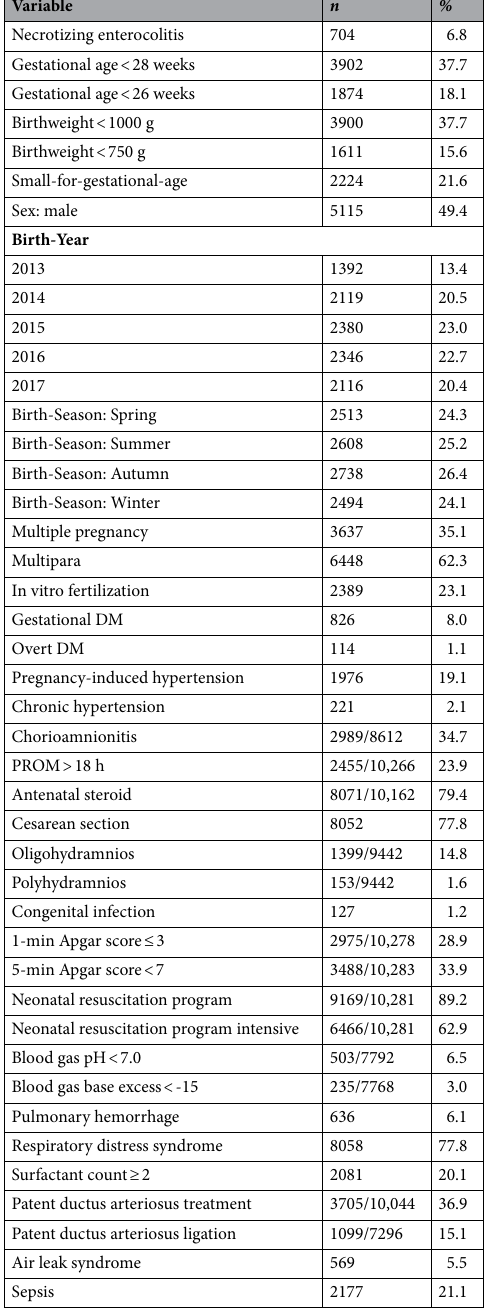
Table 1. Descriptive Statistics: Necrotizing Enterocolitis and Categorical Predictors. Abbreviations: DM, Diabetes mellitus; PROM, Pre-labor rupture of